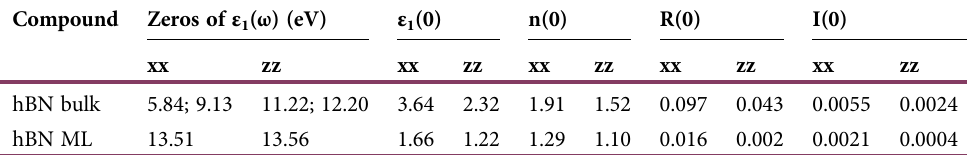
Table 2 Static values of optical